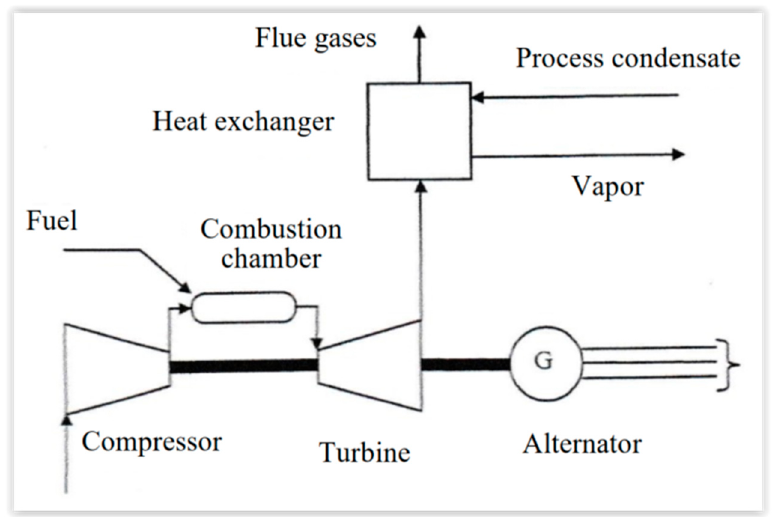
Figure 4. Scheme of a CHHP with Gas Turbine engine [17].